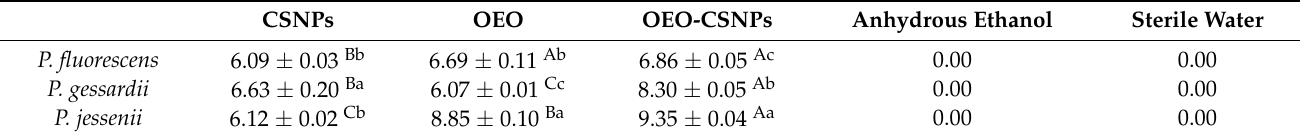
Table 5. Antimicrobial activities of OEO before and after encapsulated in CSNPs. CSNPs OEO OEO-CSNPs Anhydrous Ethanol Sterile